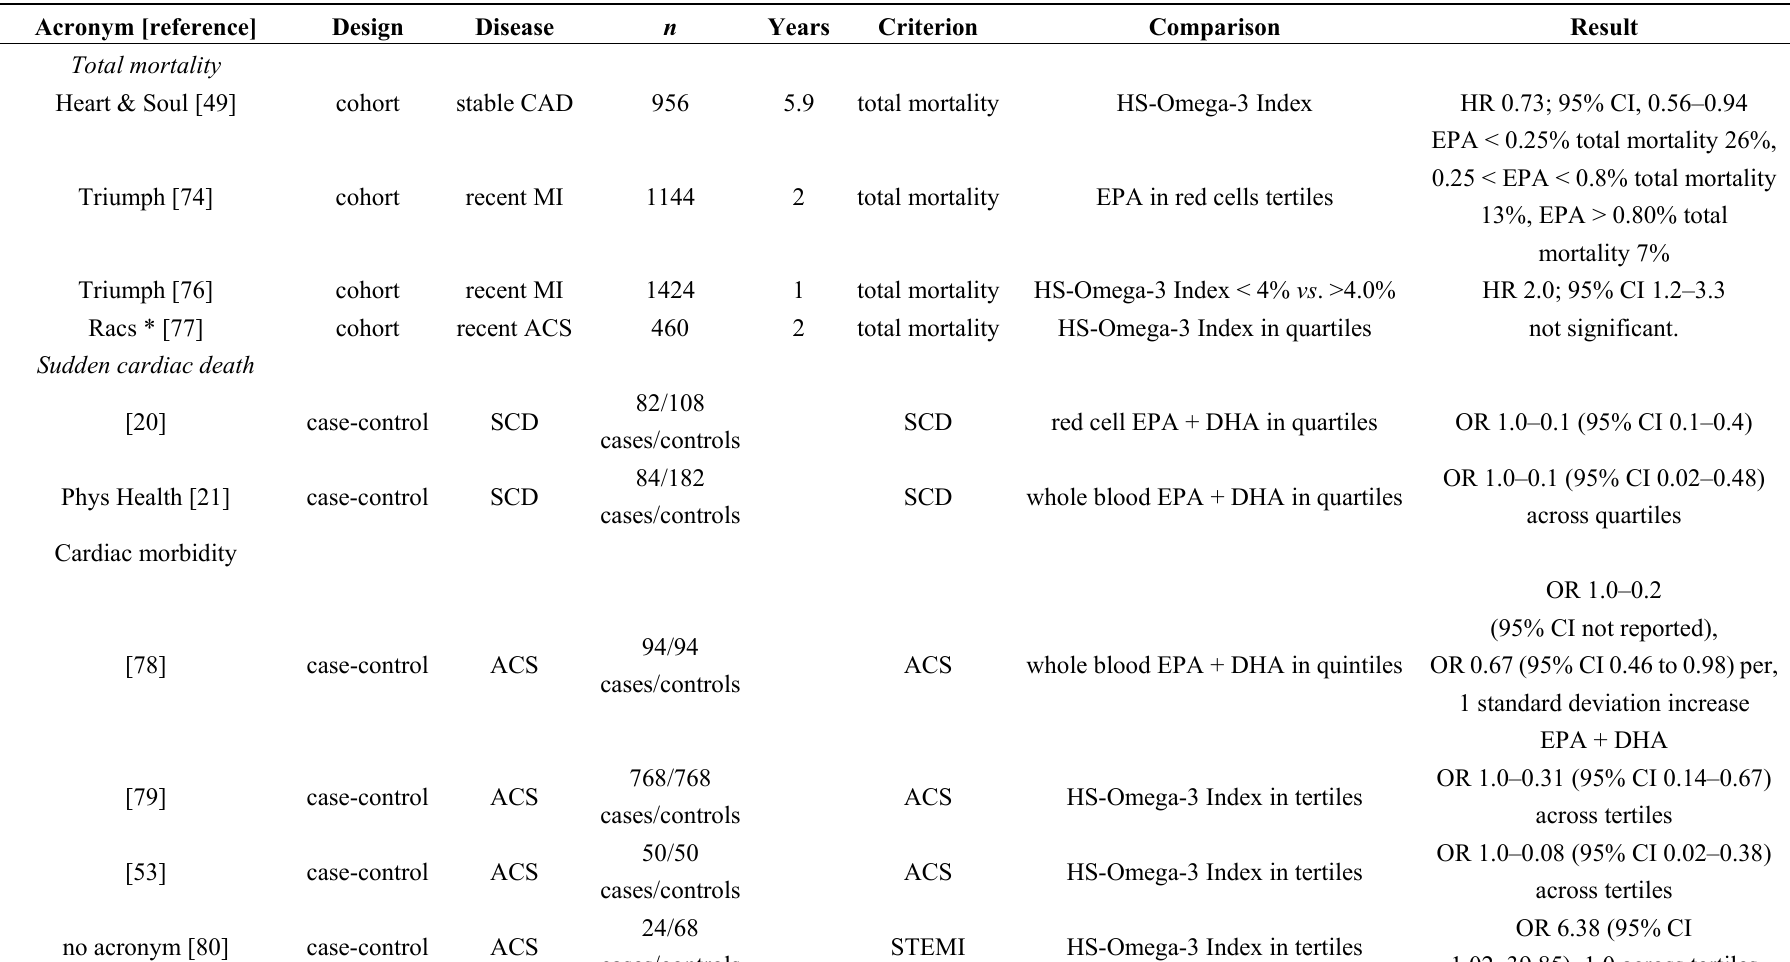
Table 2. Summary of epidemiologic studies relating the Omega-3 Index to cardiovascular